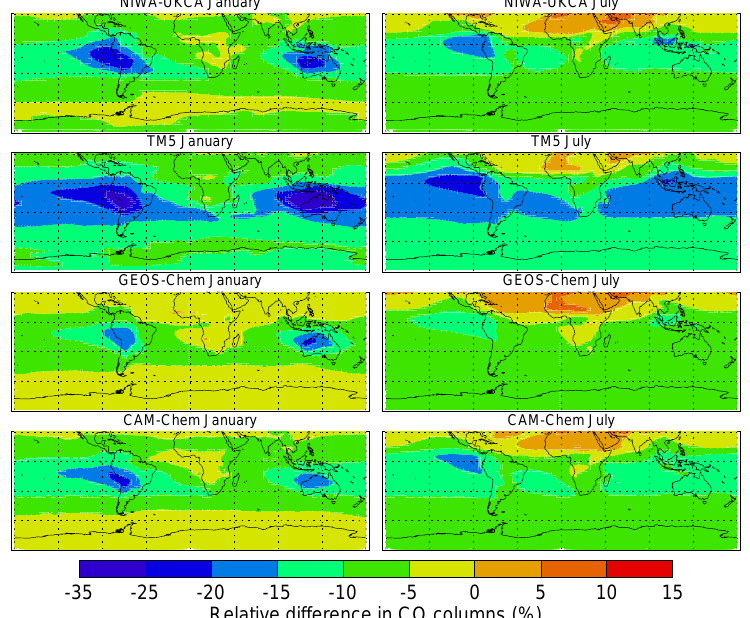
Figure 17. Relative differences (%) in modelled CO columns between the LPJ-GUESS and the CLM-MEGANv2.1 simulations from four models for January (left) and July (right). Results are expressed as “100 × ( CO LPJ-GUESS − CO CLM-MEGANv2.1 )/ CO CLM-MEGANv2.1 ”. Data are averaged over 2004–2008.